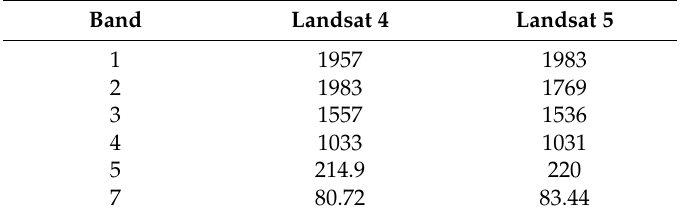
Table 1. Solar irradiance ESO-atmospheric values’ average for Landsat